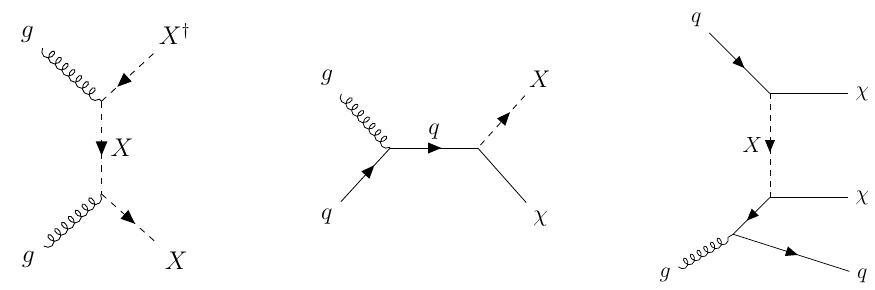
Figure 8. Feynman diagrams for processes at the LHC. The lines follow the same notation as in figure 7. In particular, from left to right, we draw the pair-production of mediators, the associated production of DM with a mediator, and the DM pair production with ISR